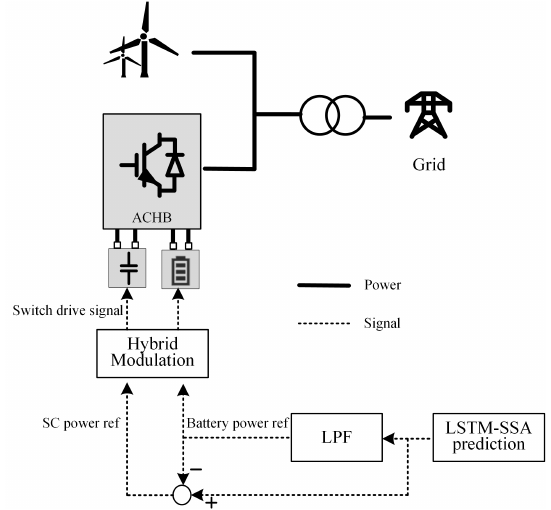
Figure 10. The flow chart of proposed power distribution strategy